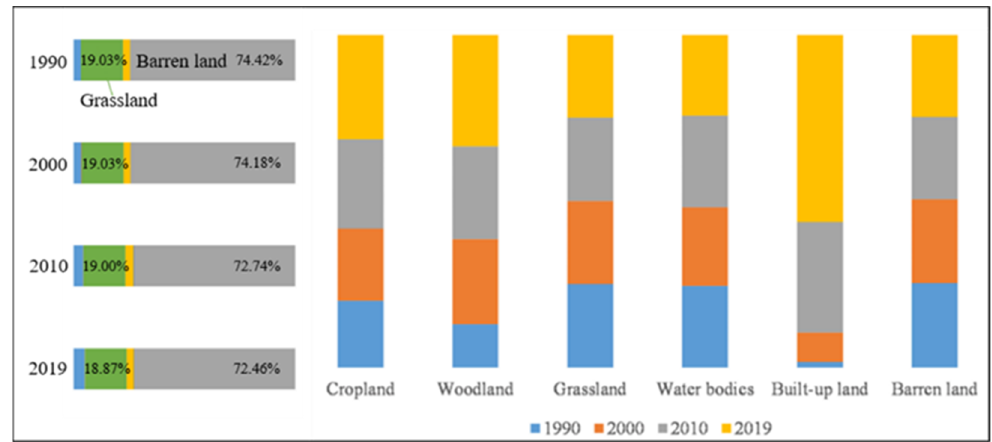
Figure 4. Land-use type changes in the Tarim River Basin.